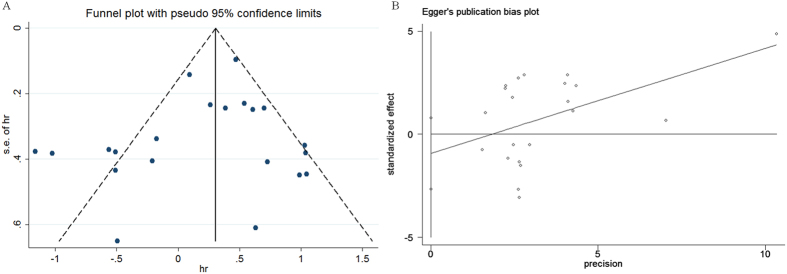
Funnel plots and Egger’s test in the context of OS without and with trim and fill.The pseudo 95% CI is computed as part of the analysis that produces the funnel plot and Egger’s test, and corresponds to the expected 95% CI for a given standard error (SE).